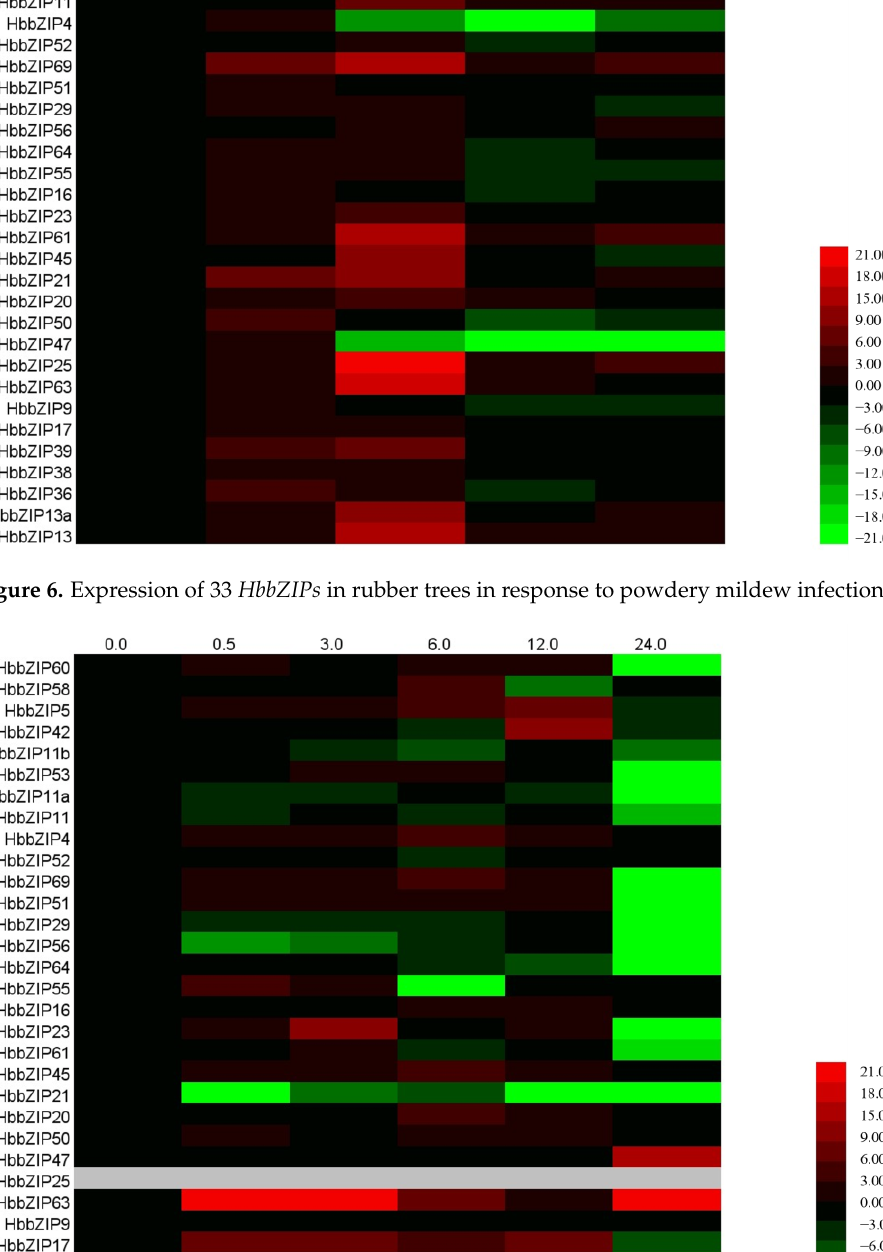
Figure 7. Expression of 33 HbbZIPs in rubber trees in response to glyphosate